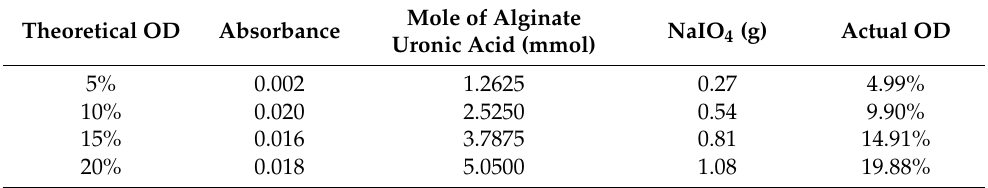
Table 1. Oxidation reaction parameters with NaIO 4 for OSA with various OD. Theoretical